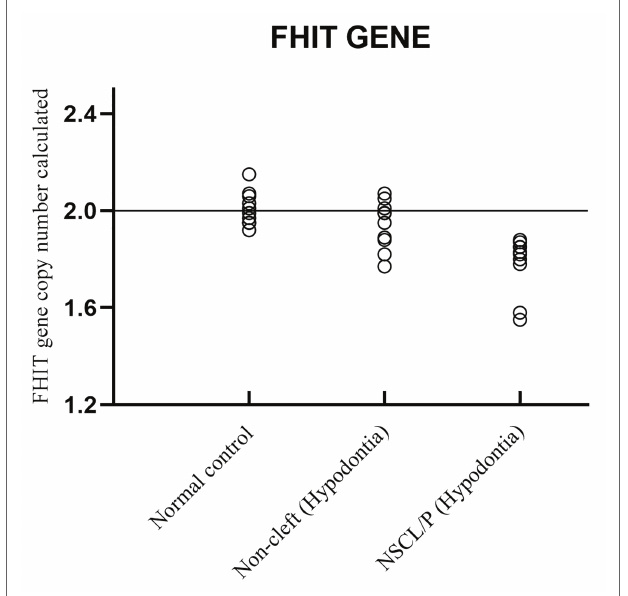
FIGURE 6 | Scatter plot indicated copy number calculated value of FHIT among NSCL/P with hypodontia, non-cleft with hypodontia and normal